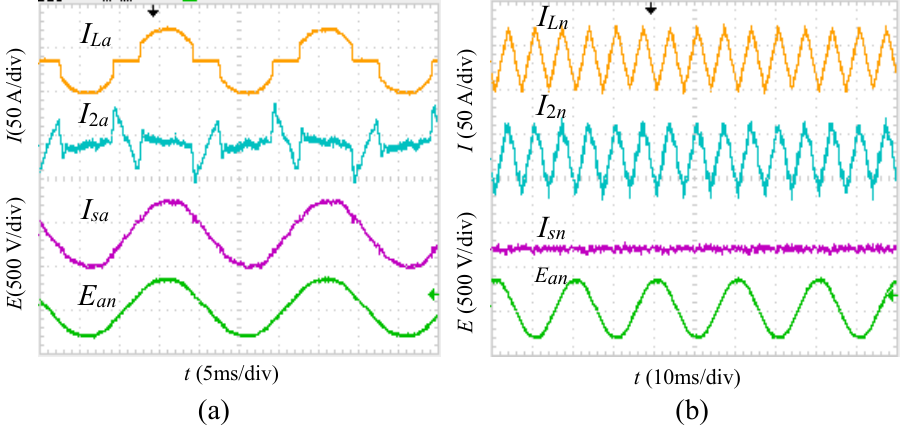
Figure 17. Waveforms in harmonic compensation ( a ) in phase A ( b ) in phase